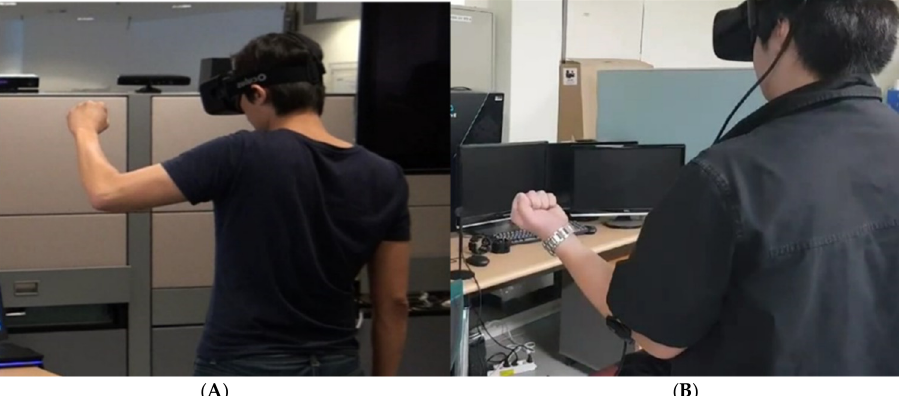
Figure 20. ( A ) Wrong behavior of lifting a virtual object in “Force Arrow.” ( B ) Right behavior of lifting a virtual object in